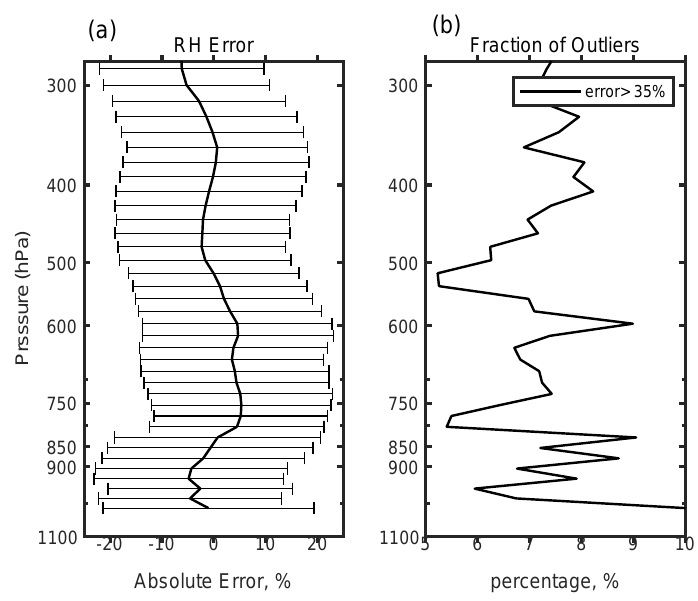
Figure 8. ( a ): The vertical distribution of the average RH biases and uncertainties (RMS). The vertical averaged biases, and uncertainties from the surface to 280 hPa (10 km) are shown in panel ( a ). The biases and uncertainty are based on the absolute error which is the difference from the referenced radiosonde observations. The units are %. The vertical distribution of outlier fractions is shown on the panel ( b ). The definition of the outlier is that the difference between the FY4A measurements and radiosonde measurements is greater than 35% (or 2 σ